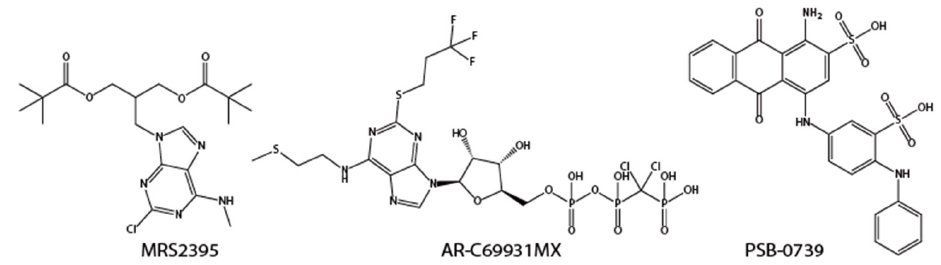
Figure 4. Structures of listed P2Y receptors